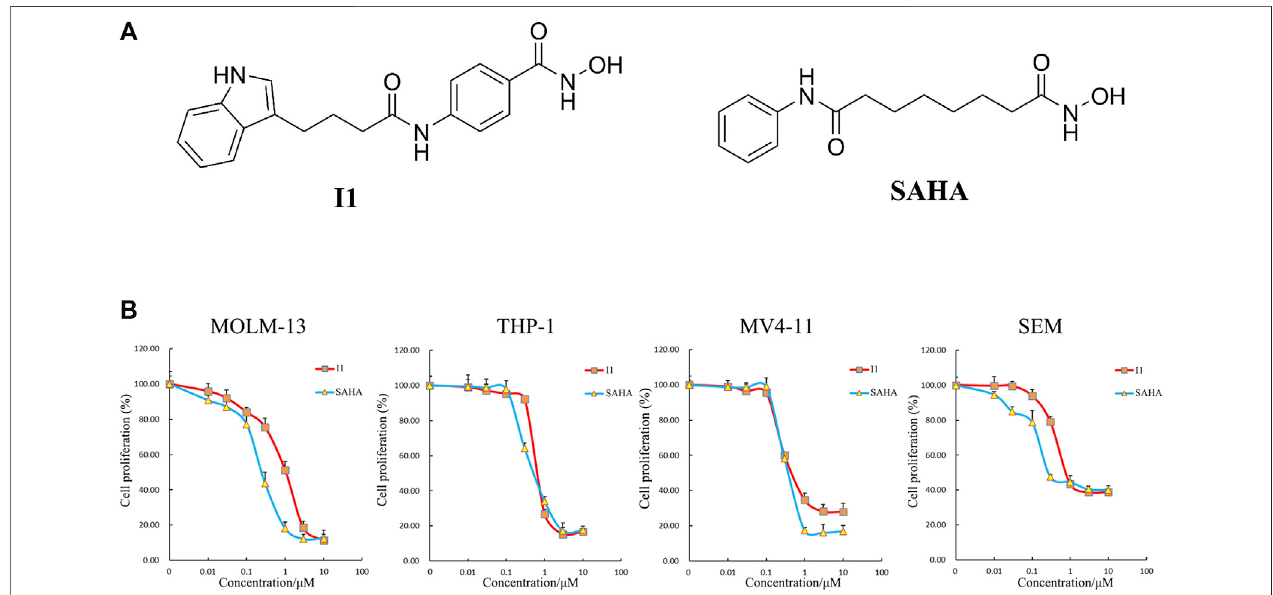
FIGURE1| I1inhibitedtheproliferationofMOLM-13, THP-1, MV4-11and SEMcells. (A) Thechemicalstructure ofI1and SAHA. (B) CCK-8 assayoncellstreated with different concentrations of I1 or SAHA (0 – 10 μ M) for 72 h. Data presented as mean ± SD. The CCK-8 assay was carried out for three times in triplicate.